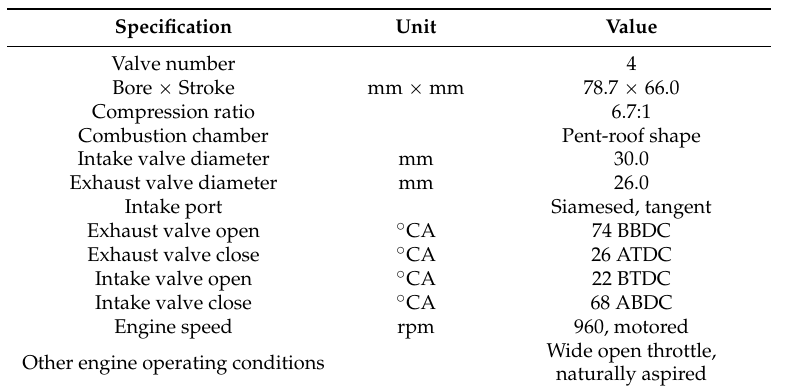
Table 1. Main specifications of FOX350 optical engine and operating condition. Before bottom dead centre: BBDC; after top dead centre: ATDC; before top dead centre: BTDC; after bottom dead centre: ABDC; CA: crank